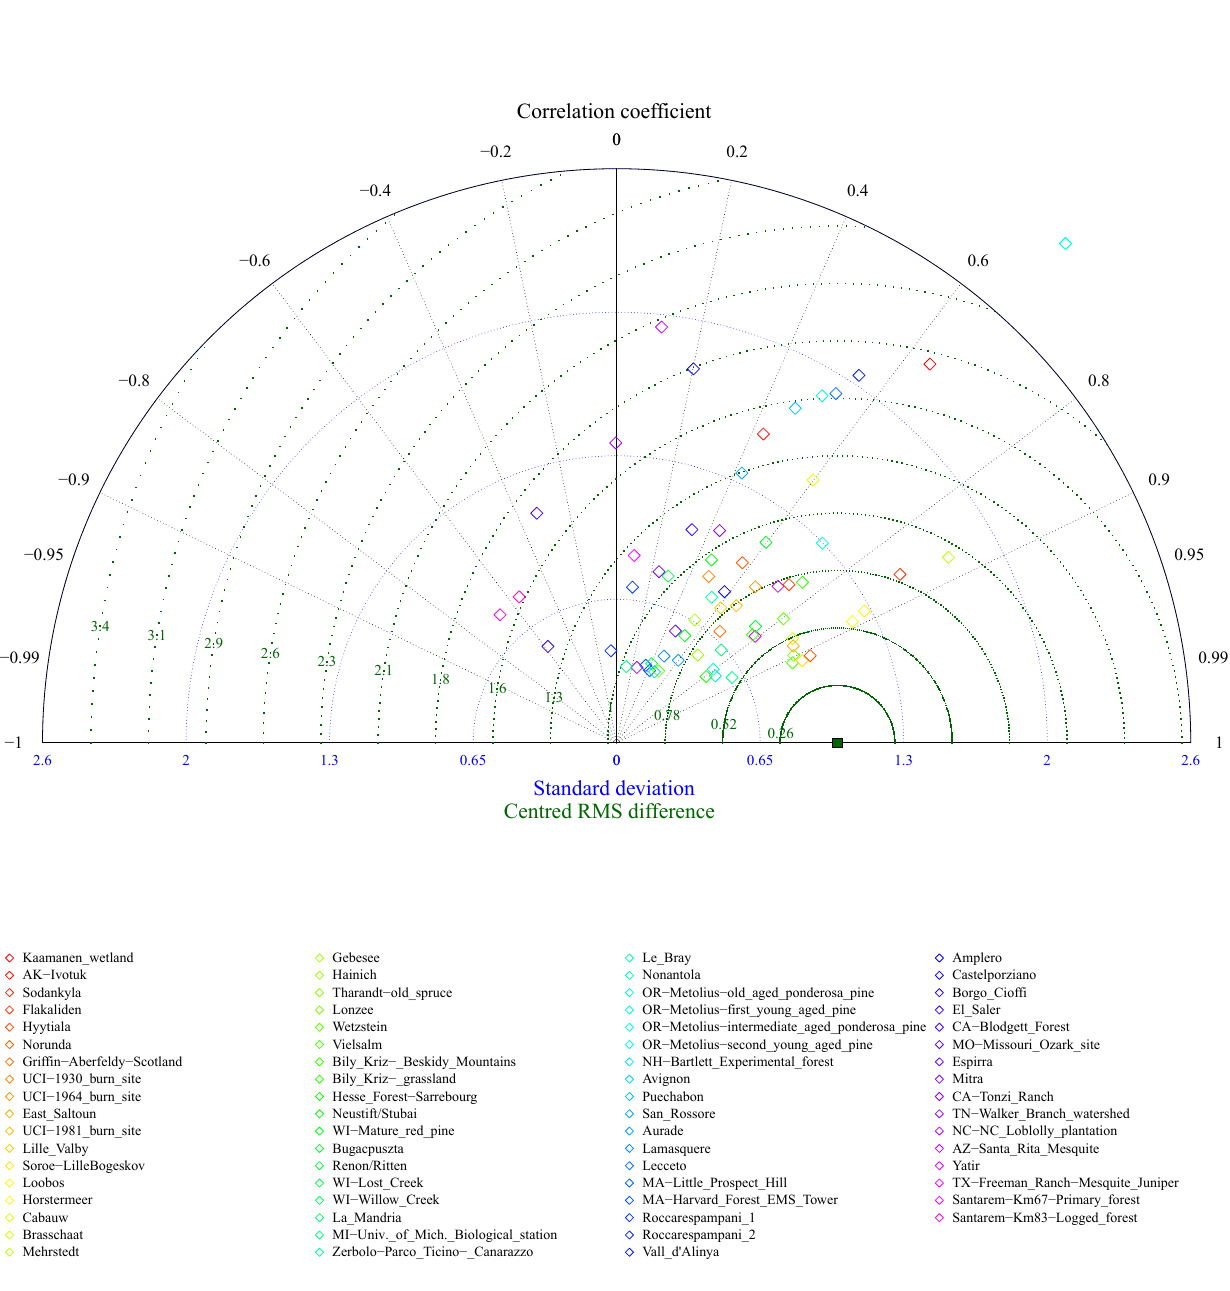
Figure 3. Net ecosystem exchange rate measured at eddy flux towers: ORNL DAAC (2011). Available online at FLUXNET (http://fluxnet. fluxdata.org/data/la-thuile-dataset/). Sites (colours) are ordered from north to